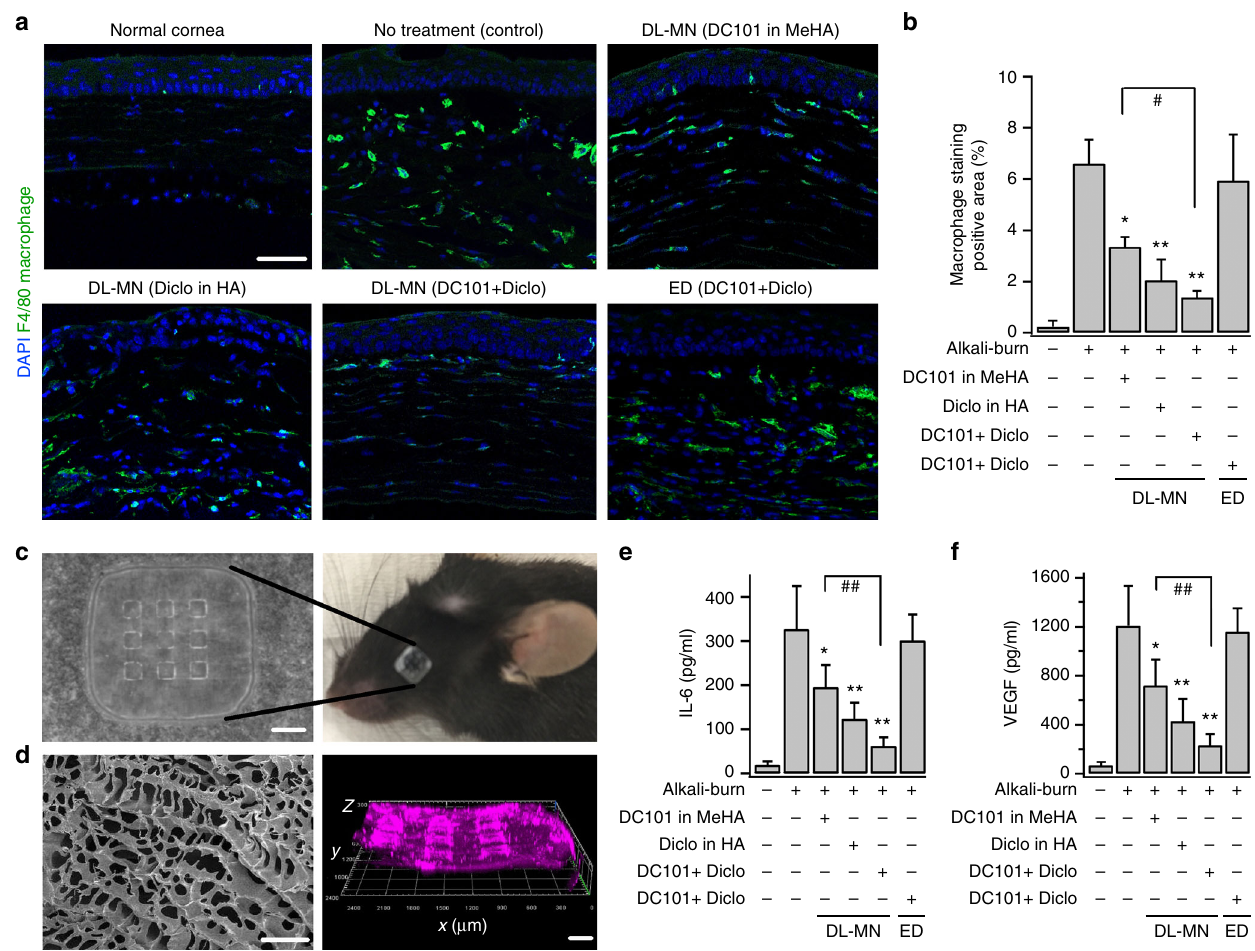
Fig. 9 In fl ammation assessment of combinational therapy using DL-MN patch. Mouse eyes were treated differently 2 days after being in fl icted with alkali- burn, and examined at day 7. a Immunohistochemical staining of the cornea with a speci fi c macrophage marker — F4/80 surface antigen (green colour). Scale bar = 50 µ m. b Quanti fi cations of macrophage accumulation (% of positive staining of F4/80; ED: eye drop) ( n = 4). c – f Cytokine concentrations in collected tear fi lm of differently treated eyes. Tear fi lms were collected with MeHA-based MN-free eye patches (patches were put on the eyes for 1 min